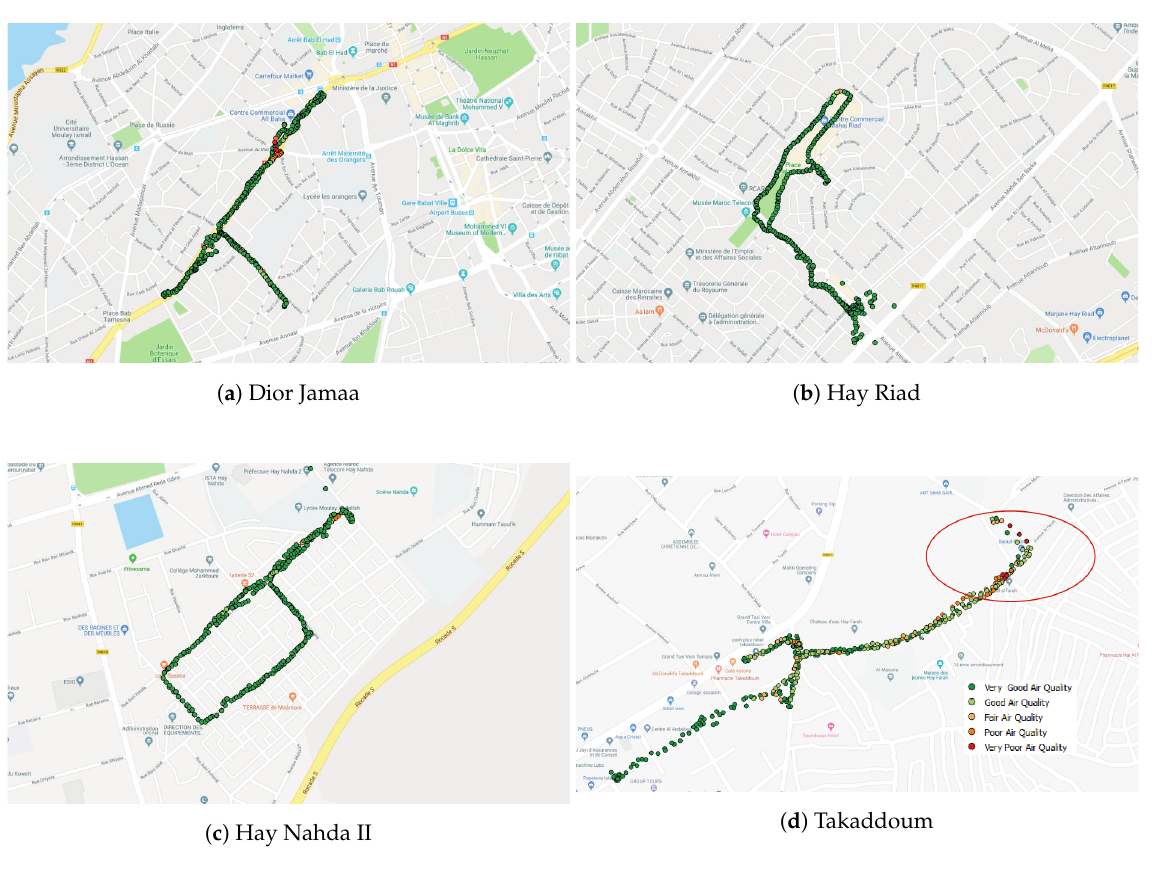
Figure 10. QGIS-based visualization of some of the measurements collected with mobile sensor nodes.